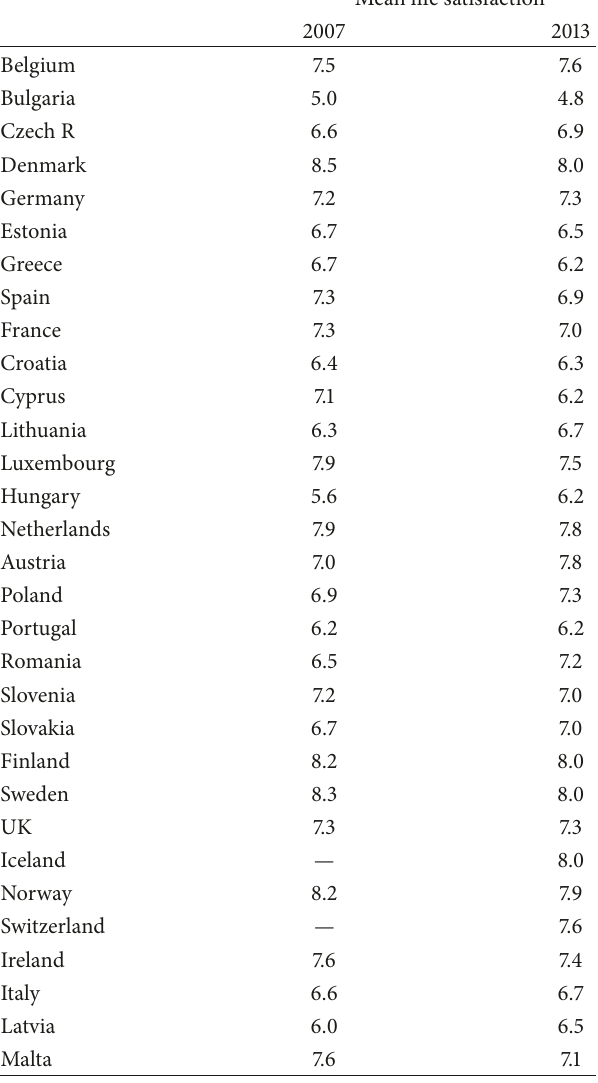
Table 1: Mean scores life satisfaction per country in 2007 and 2013.